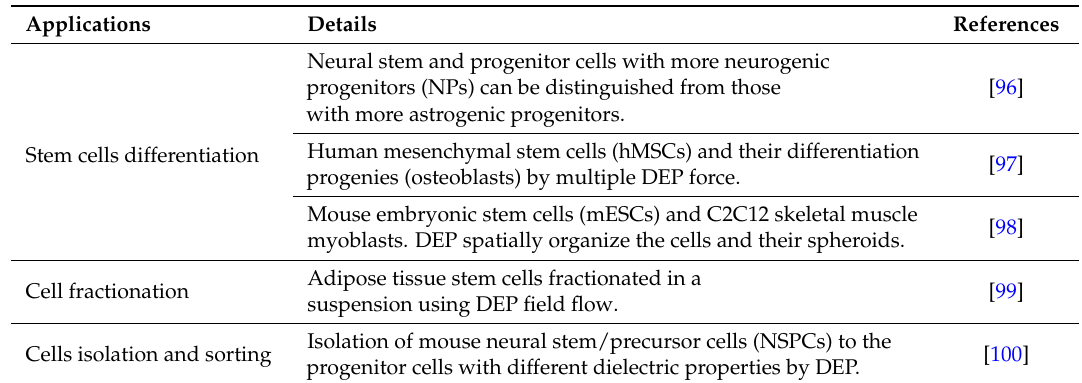
Table 4. DEP studies on stem